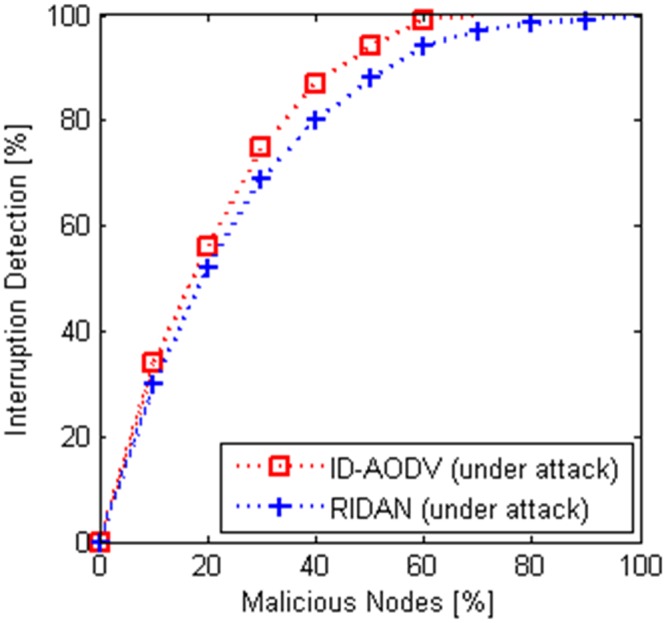
Comparative analysis of impact of percentage of malicious nodes on interruption detection under static condition.